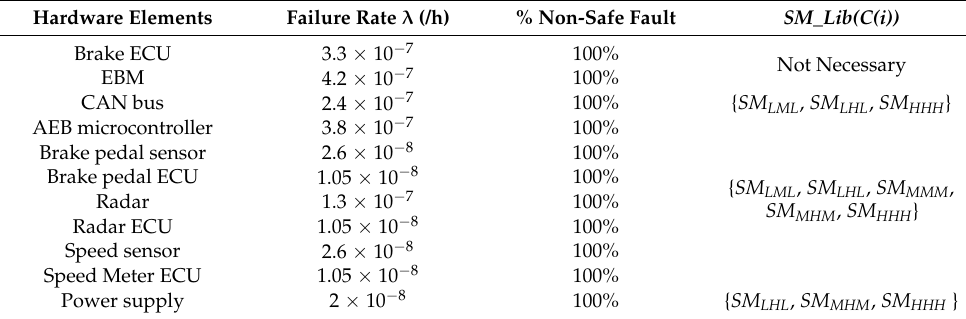
Table 11. Hardware element’s failure rates of the AEB system.